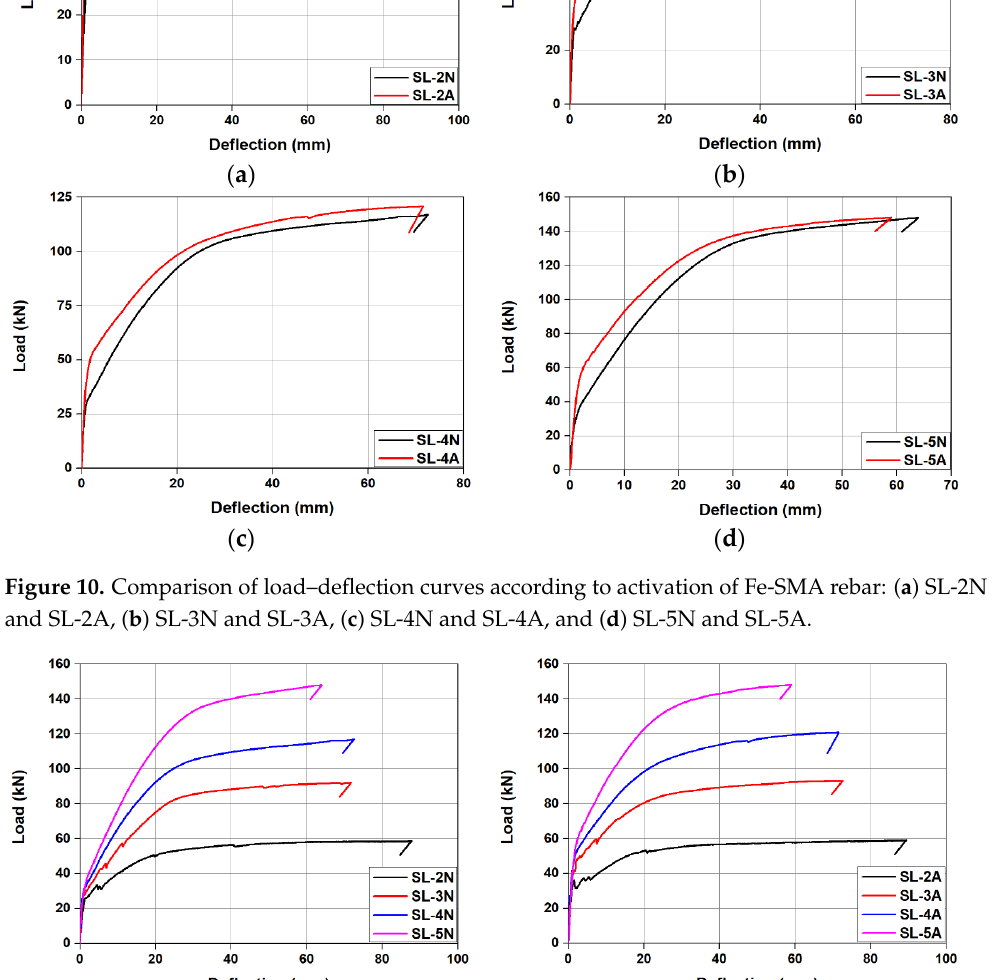
Figure 11. Comparison of load – deflection curves according to amount of Fe-SMA rebar. ( a ) Non- activated specimens. ( b ) Activated specimens.